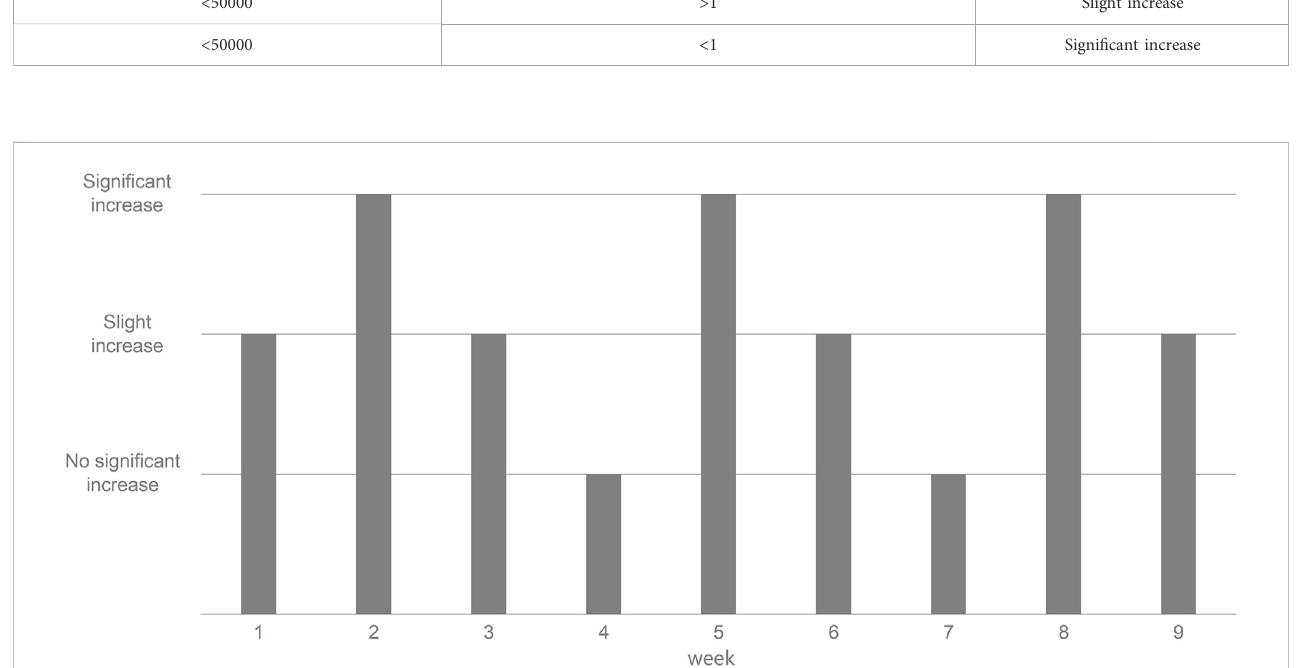
FIGURE 9 Trends in the refugee population by the grade within 9 weeks after the beginning of the war.